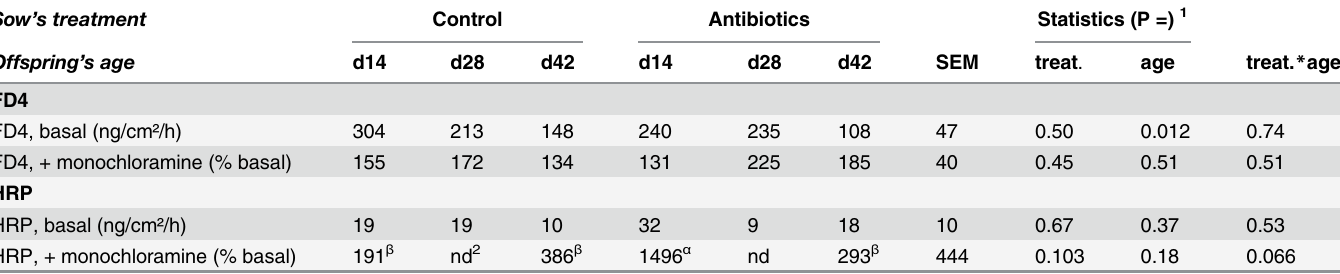
Table 1. Mucosal-to-serosal fl uxes of FD4 and HRP for basal and monochloramine-stimulated colonic mucosa of pigs born to control or antibiotic-treated sows and slaughtered at different ages (LSmeans and SEM, n = 6 – 8 per treatment and age). Sow ’ s